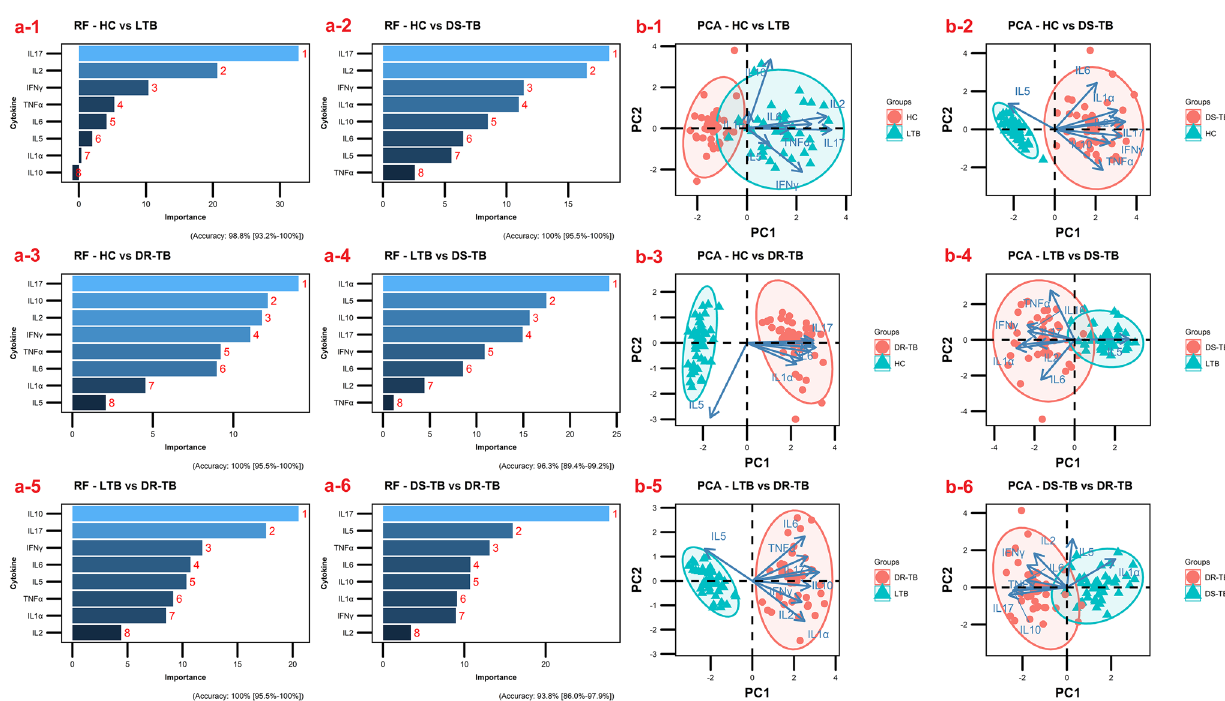
Figure 5. Sub-group comparisons of top 8 cytokines by Random-forest analysis ( a-1 HC vs LTB, a-2 HC vs DS-TB, a-3 HC vs DR-TB, a-4 LTB vs DS-TB, a-5 LTB vs DR-TB and a-6 DS-TB vs DR-TB) and